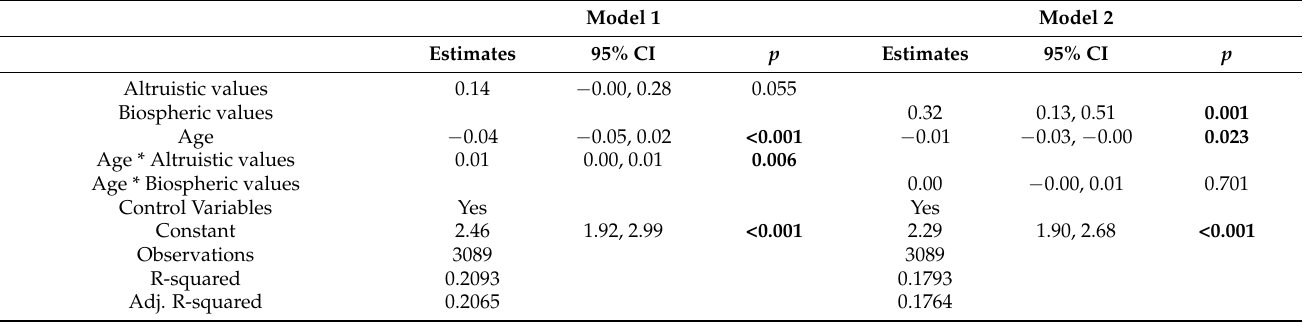
Table 7. Moderating effect of age on the relationship between altruistic values and behavioral intention.